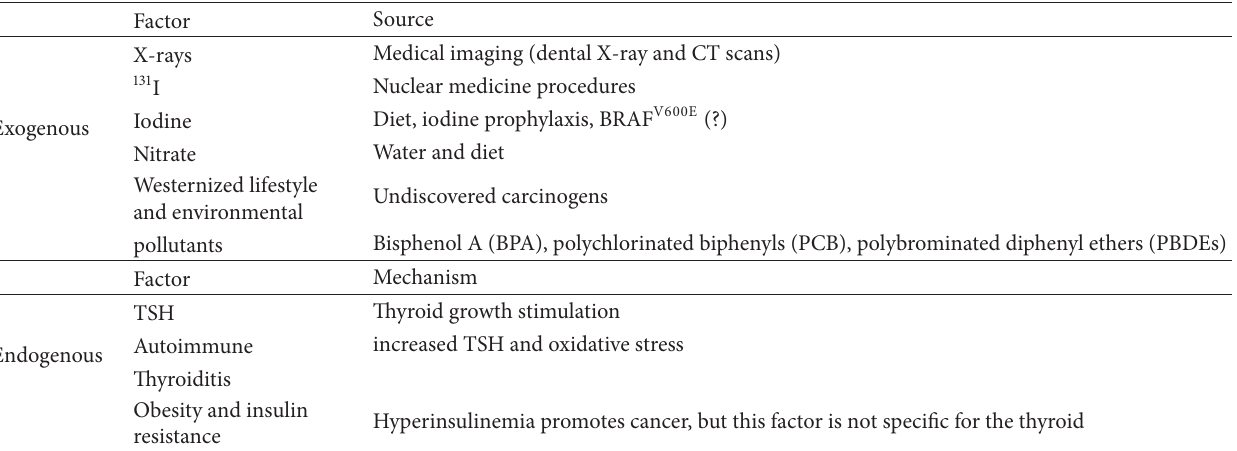
Table 3: Potential carcinogenic factors thyroid